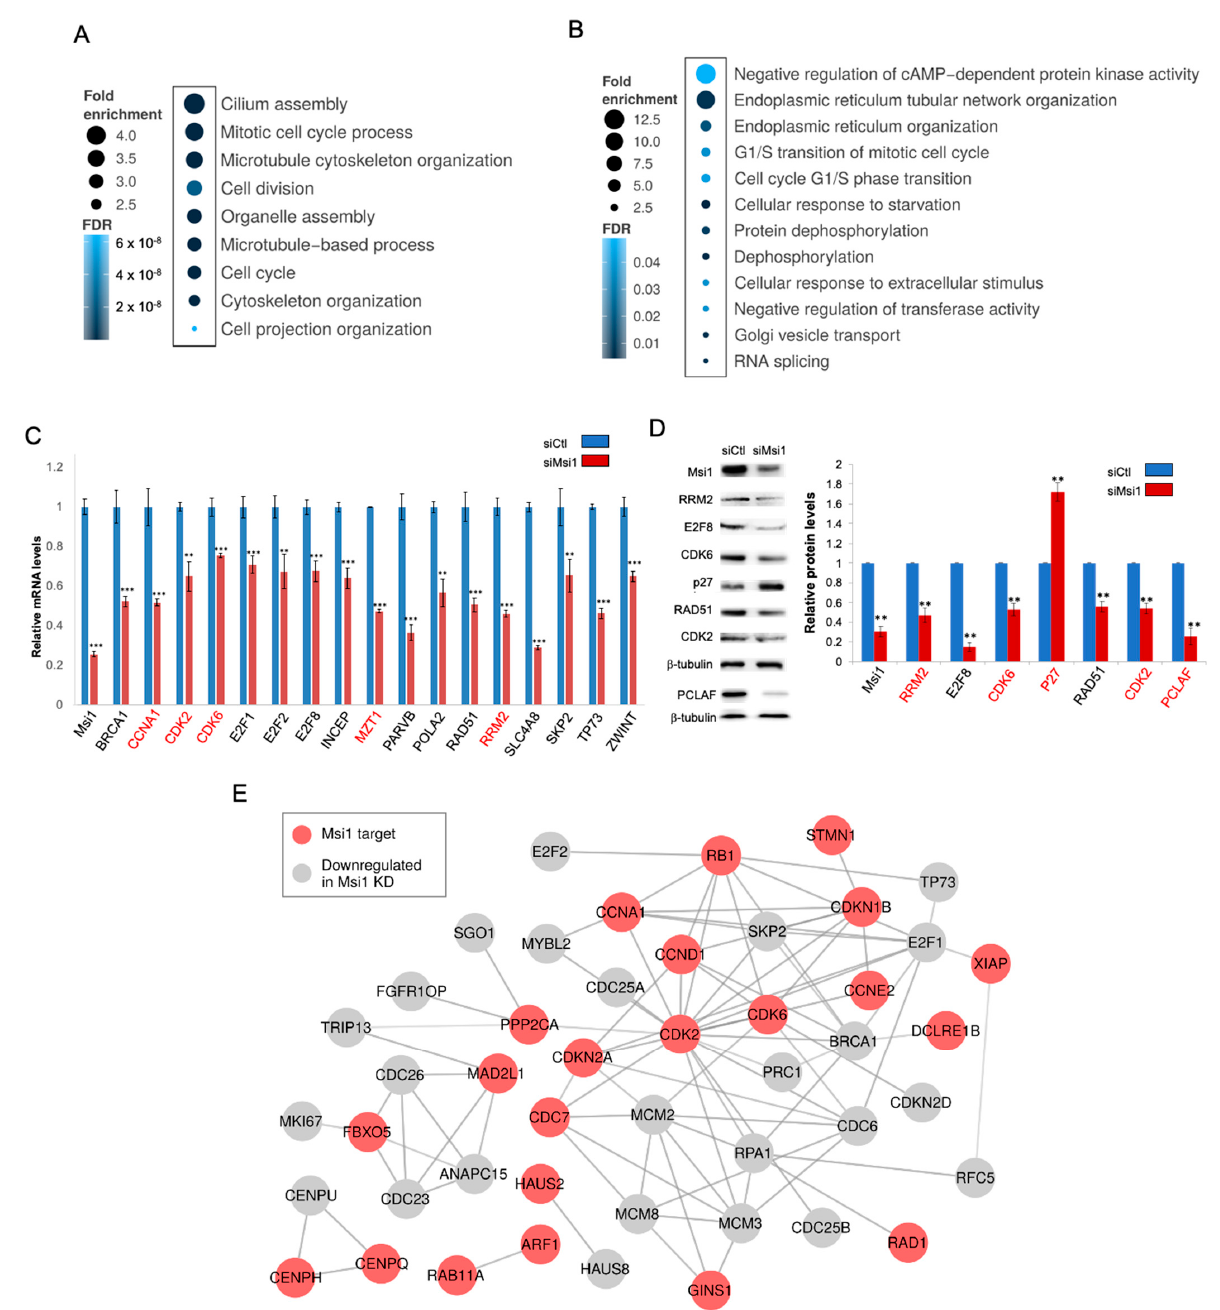
Figure 3. Musashi1 regulates a network of genes implicated in cell cycle/division in medulloblastoma G4 cells . Gene ontology-enriched terms (biological processes) associated with genes downregulated after Msi1 knockdown ( A ) and Msi1 targets ( B ) identified by RNA-seq and RIP-seq, respectively. GO analysis was conducted using Panther [30] and terms were compiled with REVIGO [31]. Expression of cell cycle/division genes in Msi1 knockdown cells (siMsi1) vs. control cells (siCtl) by qRT ‐ PCR ( C ) and Western blot ( D ). ImageJ (http://rsb.info.nih.gov/ij/index.html (accessed on 21 September 2021)) was used to compare the densities of bands and to quantify using β -tubulin as an endogenous control. Genes that were also identified as Msi1 targets are labeled in red. Statistical significance was calculated by multiple t -test (** p < 0.01, *** p < 0.001). ( E ) Protein–protein network according to STRING [34] showing cell cycle/division genes identified as Msi1 targets or downregulated in Msi1 knockdown cells. Msi1 targets (in red) were main nodes. The second layer contains genes downregulated in Msi1 knockdown